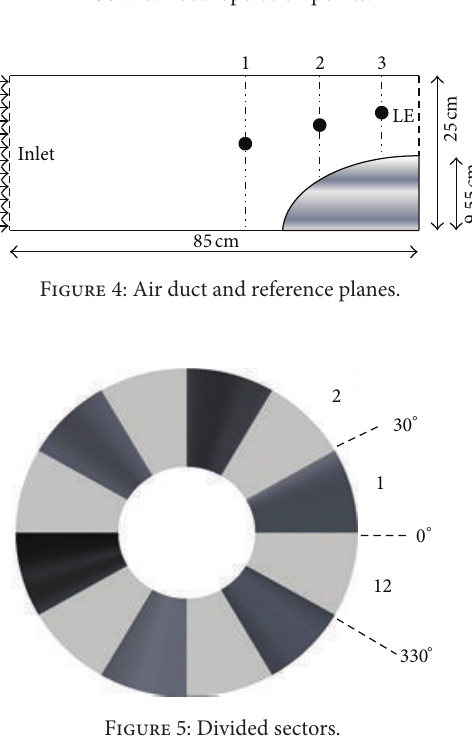
Figure 3: Local operation points.